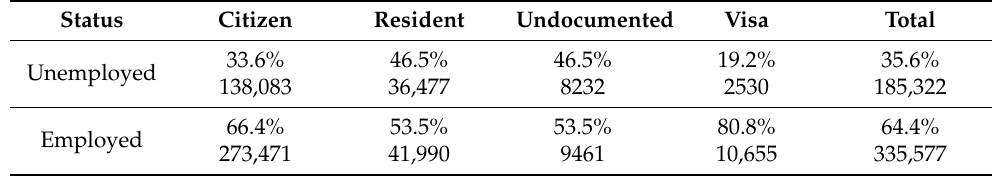
Table 1. Employment by Citizenship Status among Hispanics in El Paso, TX in